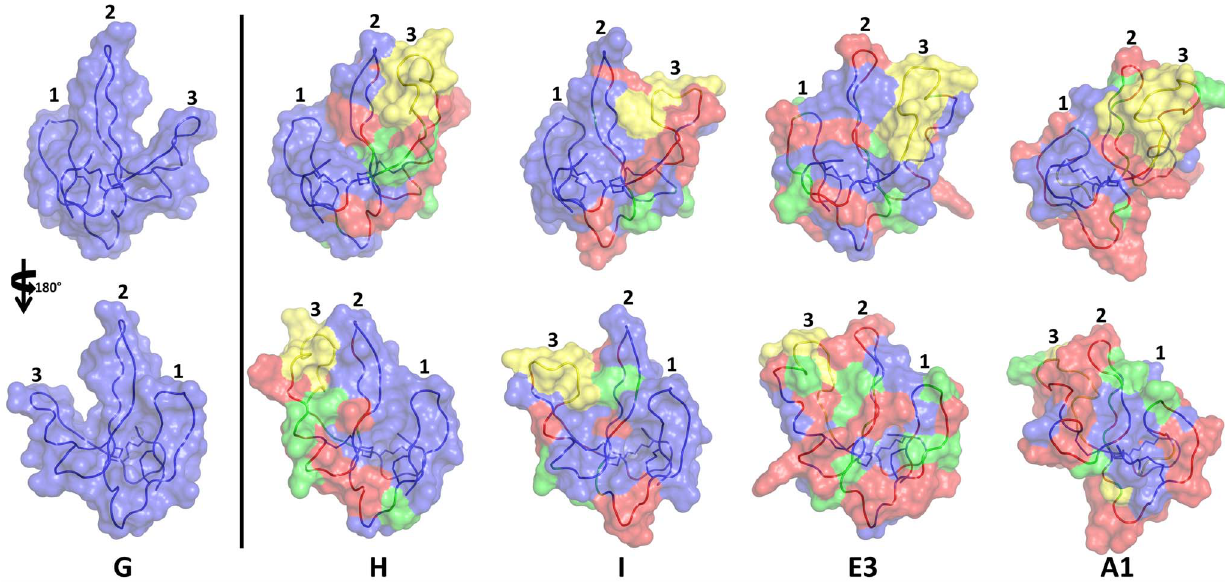
Figure 5. Homology modeling of major PMF isoforms. Homology models of four additional PMF isoforms that are highly expressed in P. shermani (isoform H, accession # JF274289; isoform I, accession # JF274304; isoform E3, accession # JF274344; isoform A1, accession # JF274380). Models are color coded according to amino acid conservation relative to PMF-G, which is included as a reference in the first panel (same residue, blue; conservative substitution, green; nonconservative substitution, red; insertion, yellow).